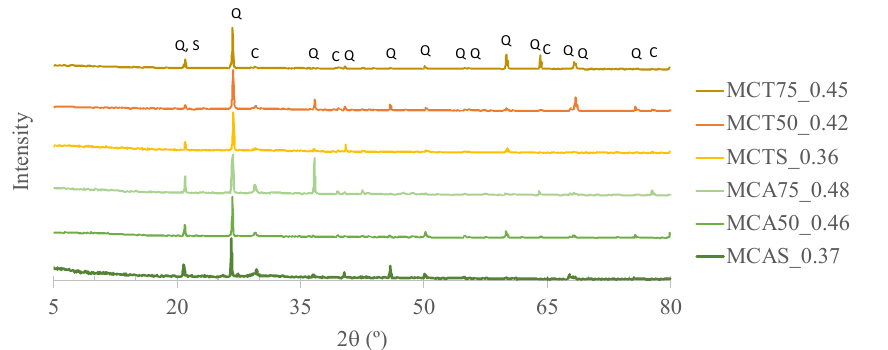
Figure 10. X-ray diffraction (XRD) patterns of specimens after 28 days of curing where Q stands for quartz, C for calcite and S for sodium aluminosilicate.